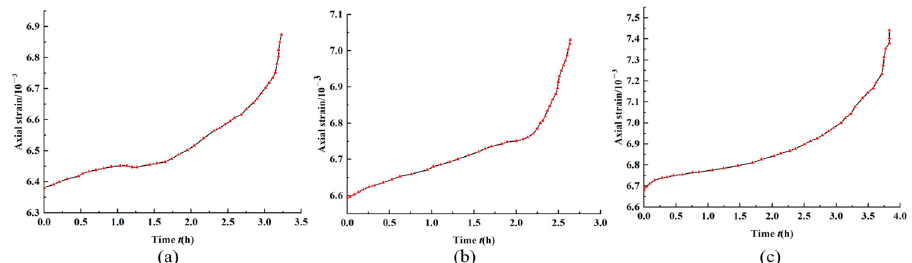
Figure 15. Curve of accelerated creep stage of specimens with different porosity; ( a ) Poriness 5~10%; ( b ) Poriness 10~15%; ( c ) Poriness 15~20%.